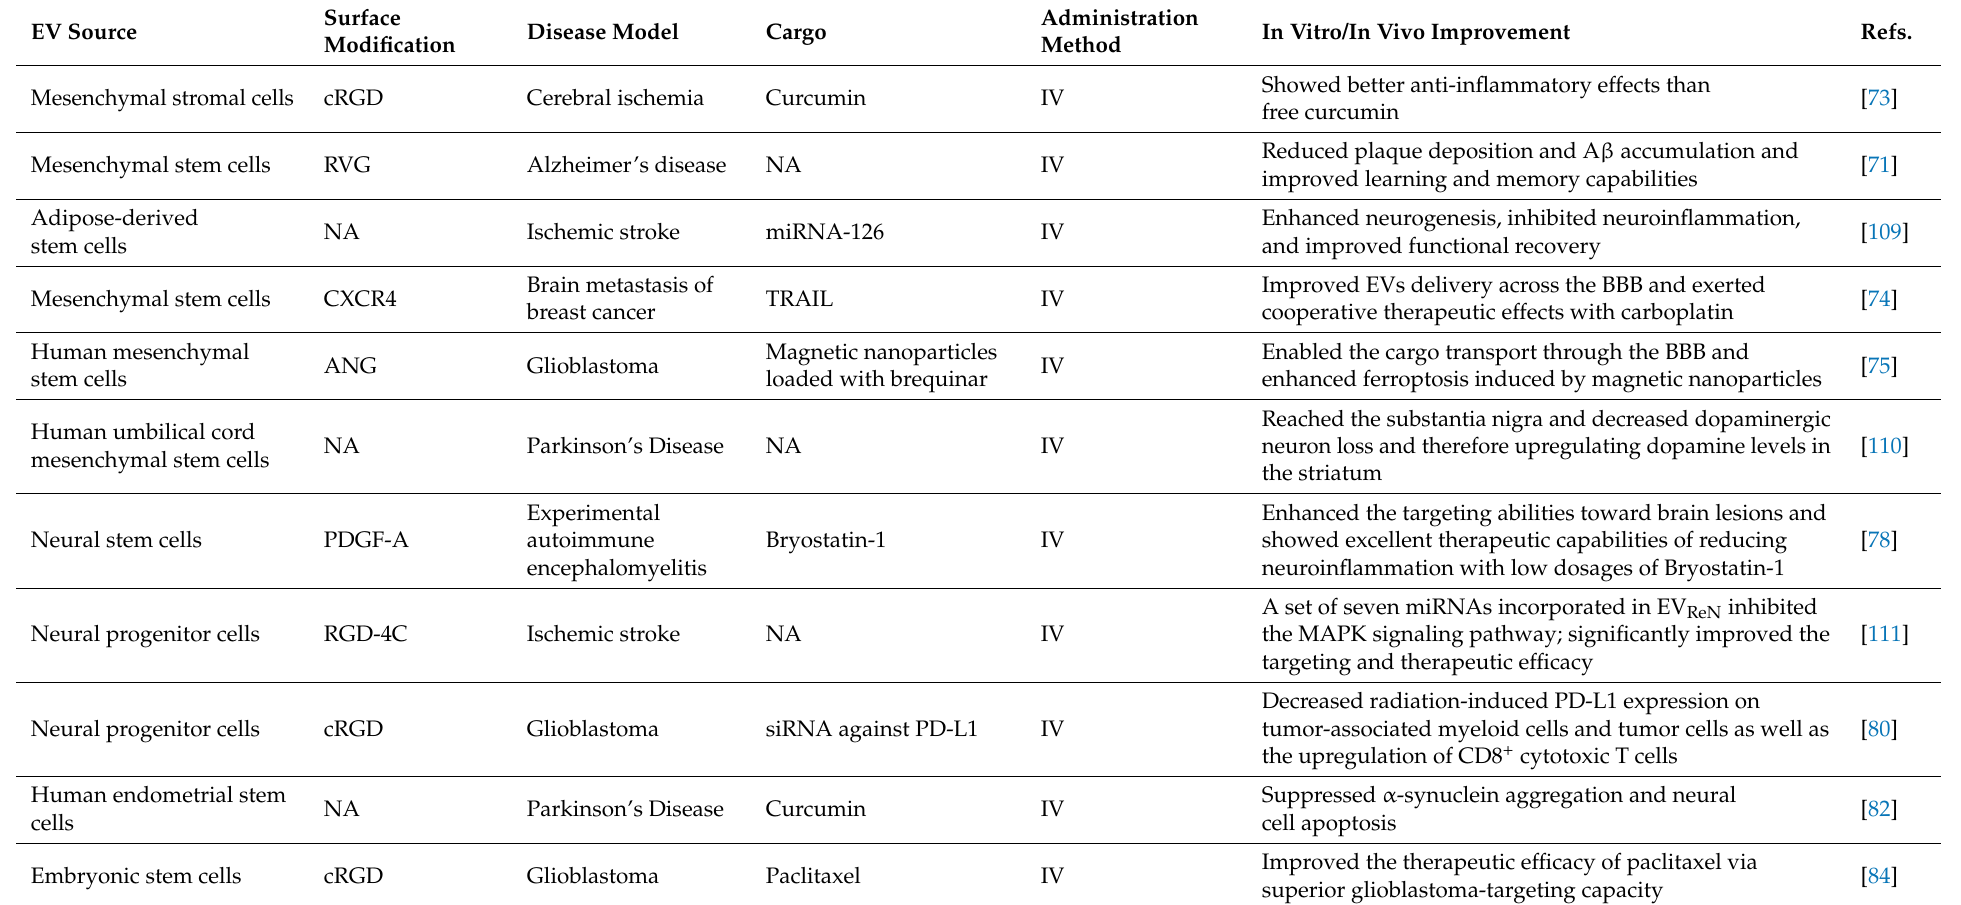
Table 2. EV-mediated BBB-crossing